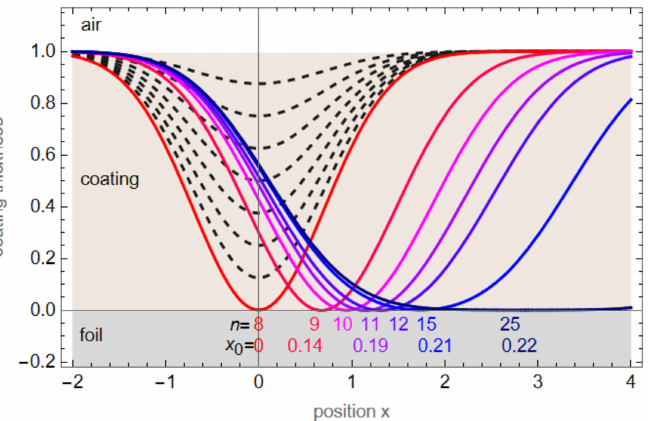
Figure 8. Graph of a Gaussian ablation profile. The light brown coating (y-axis from 0 to 1) is ablated with n = 8 consecutive pulses (dashed lines) until the crater reaches the foil. For a continuous shift x 0 from pulse to pulse, more pulses are needed to ablate the coating ( n = number of pulses).